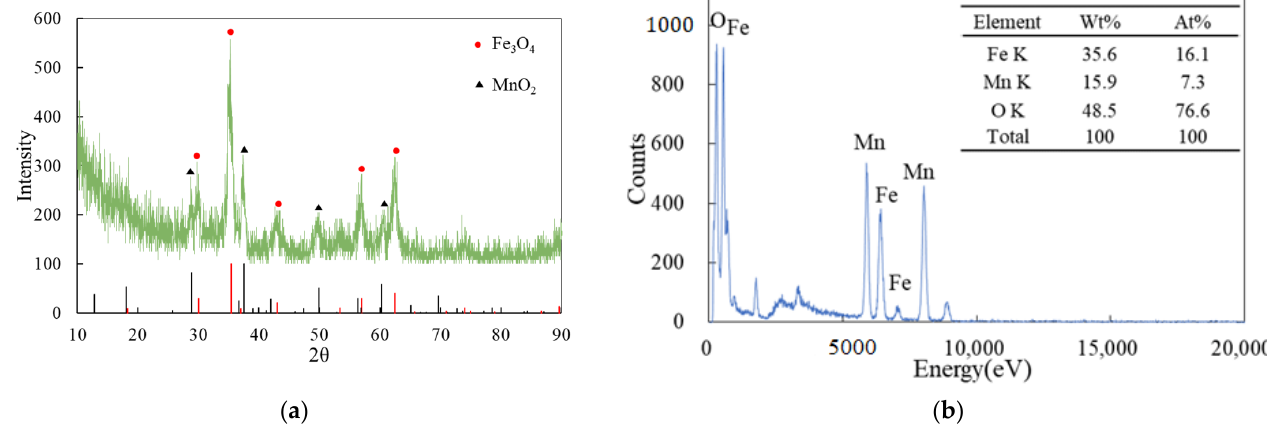
Figure 1. ( a ) X-ray diffraction pattern of Fe 3 O 4 /MnO 2 (the green line represents the XRD of Fe 3 O 4 /MnO 2 , the red lines represent the characteristic peaks of Fe 3 O 4 , and the black lines represent the characteristic peaks of α -MnO 2 ); ( b ) EDX of Fe 3 O 4 /MnO 2 .